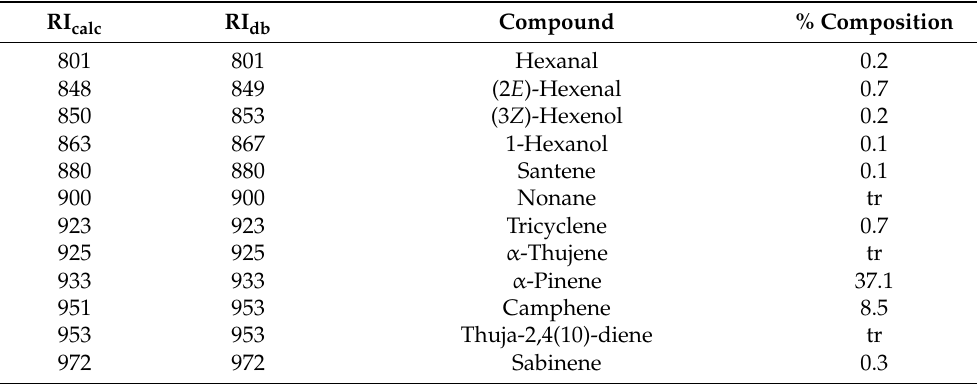
Table 3. Chemical composition of Pinus flexilis leaf essential